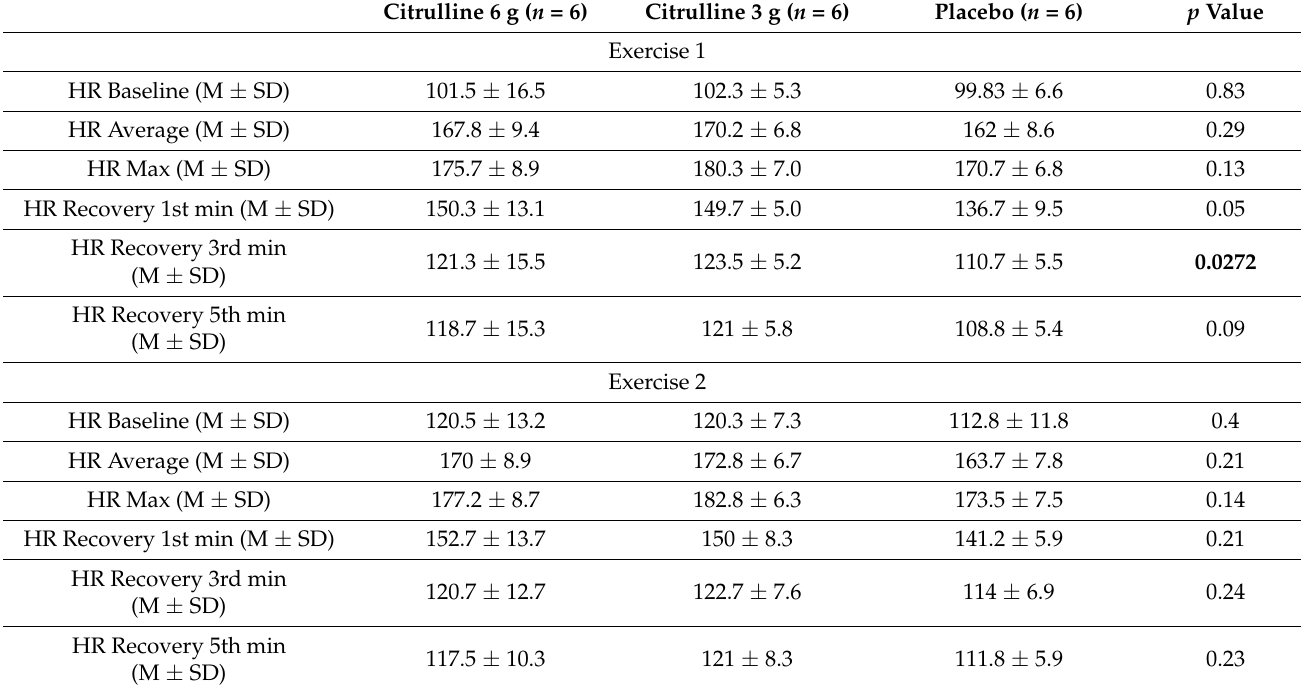
Table 2. Exercise-test heart-rate variables for all groups.